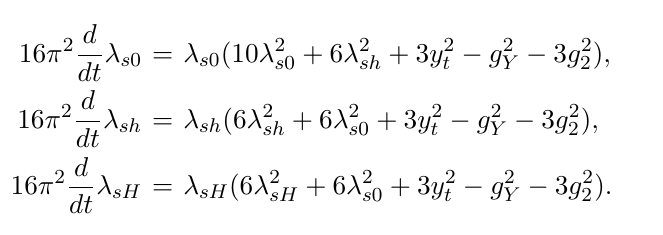
Table 2 . Tree-level parameters used for our numerical study in the F -term supersymmetric UV completion of the TMNT model with (cid:22) 0 2 solved to get vev = 174 GeV. As the IR scale in our analysis is above TeV, we use y t = 0 : 85 to account for the running e(cid:11)ects. The one-loop beta functions for the couplings (cid:21)